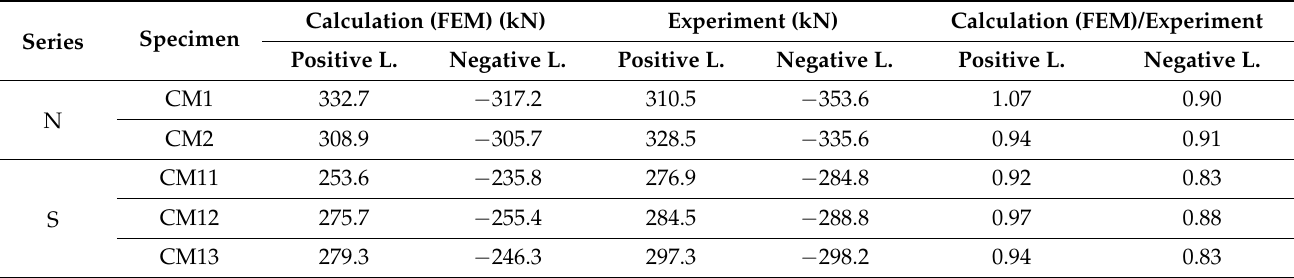
( b ) Figure 18. Minimum principal stress distribution of concrete ( R = 1.0%): ( a ) CM12; ( b ) CM13. 5. Conclusions In this study, detailed investigations on RC columns with rectangular hollow cross- sections, in building structures, were carried out to understand their structural character- istics and seismic performance. The following are the major findings obtained from this study.